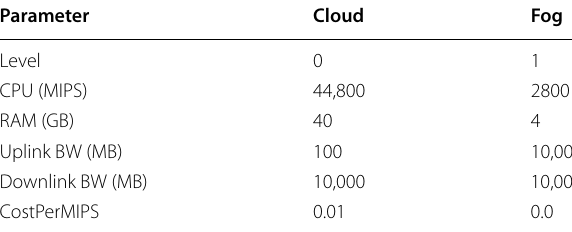
Table 3 Cloud-edge infrastructure setup